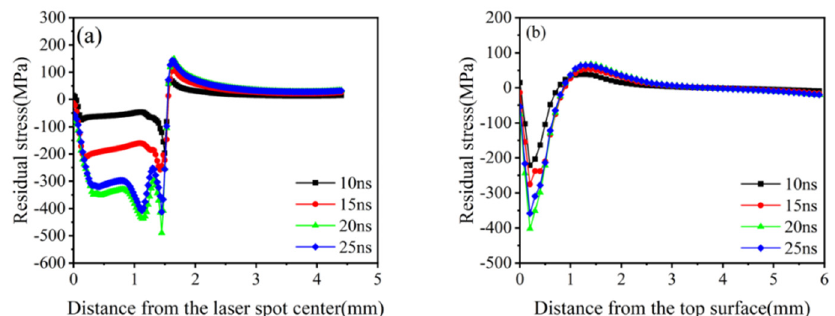
Figure 8. Residual stresses in 20CrMnTi at different pulse widths, ( a ) surface residual stress distribution; ( b ) depth direction residual stress distribution.